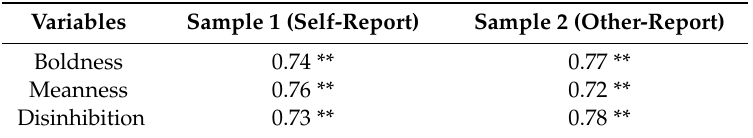
Table 3. TriPM(Work) test–retest reliability (Time 1 and Time 2 Pearson